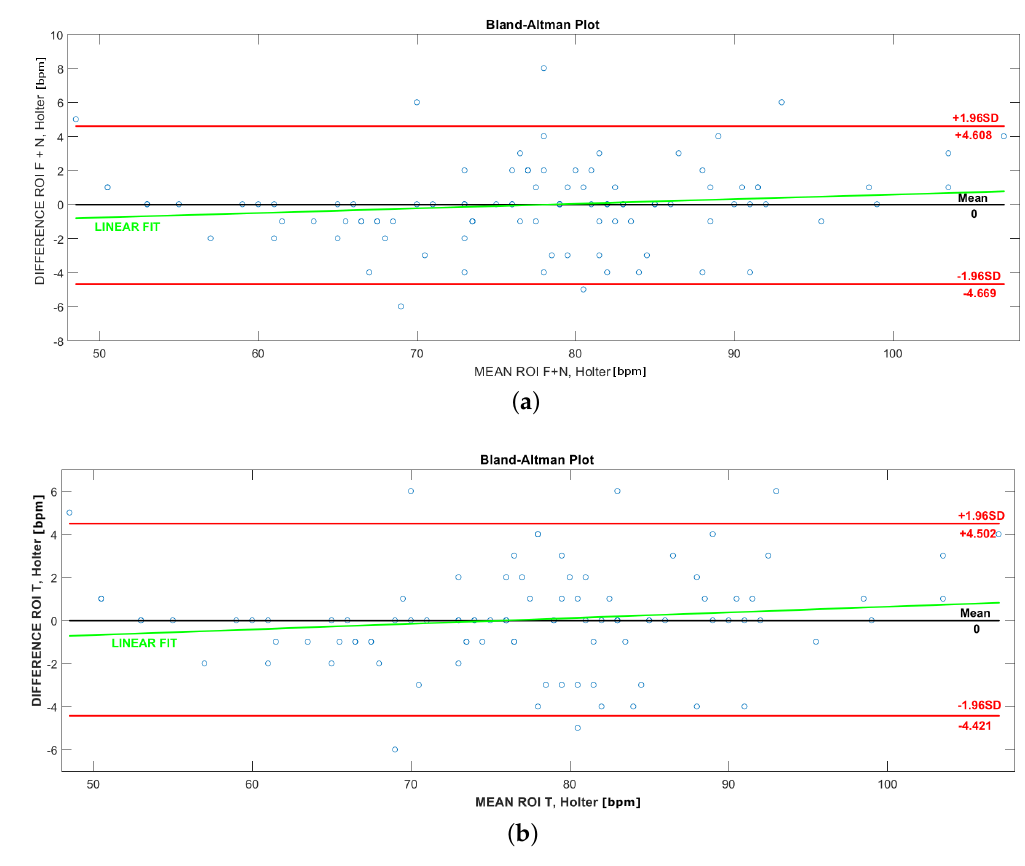
Figure 8. Best correlation values with the Bland–Altman plot, between HR values extracted by the Holter and through the proposed method in ( a ) ROI F + N; ( b ) ROI T.